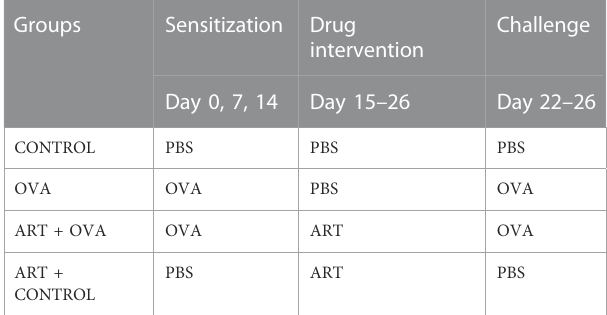
TABLE 1 Method of establishing mice model of